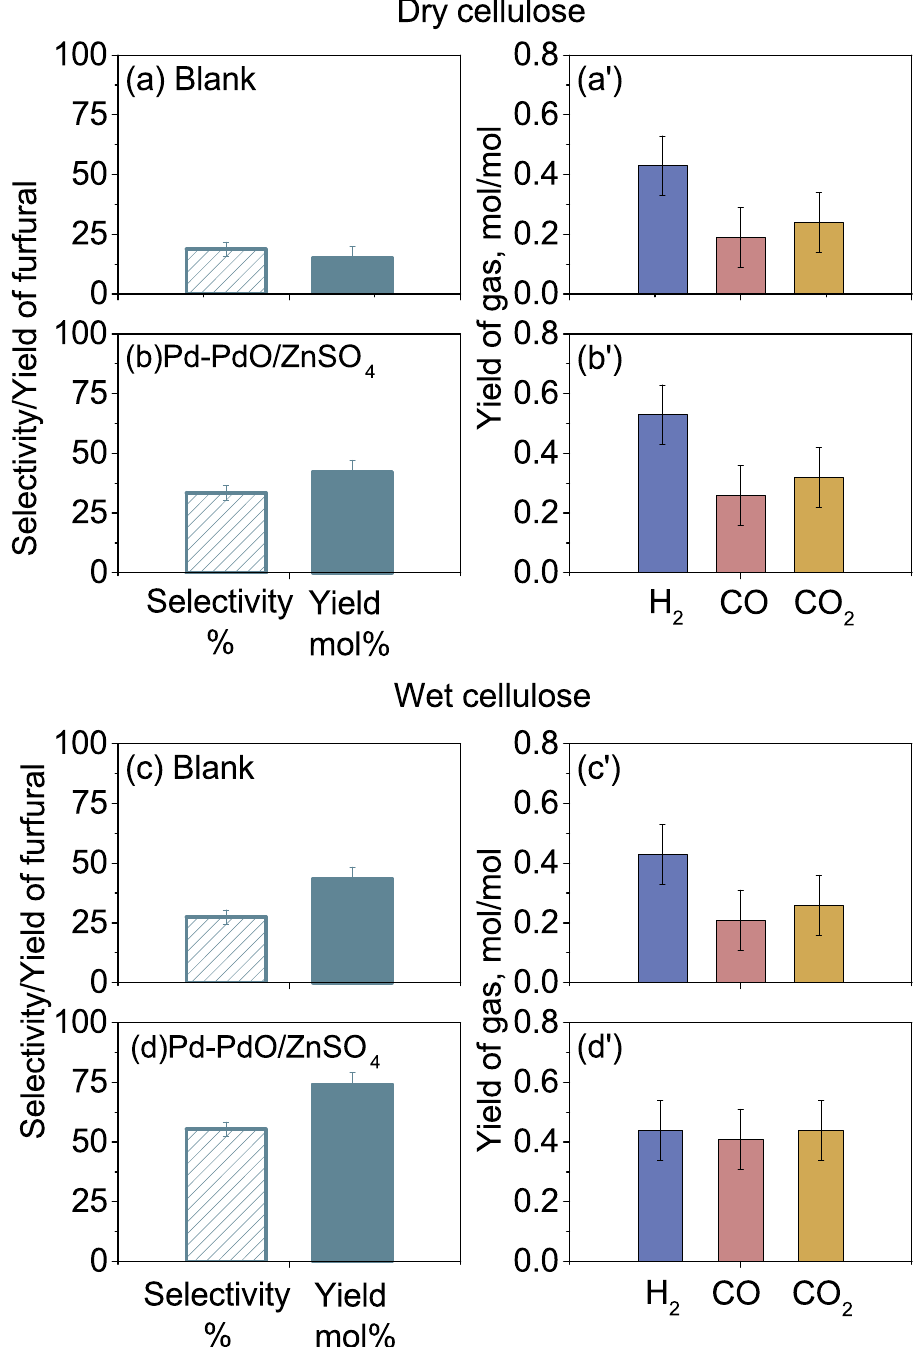
Fig. 5 | Product distribution from the pyrolysis ofdry and wet cellulose. Panels a and a ’ arefortheselectivityandyieldoffurfural,andtheyieldsofindividualgases from dry cellulose without catalysts, respectively; Panels b and b ’ are for the respective results from dry cellulose with the Pd-PdO/ZnSO 4 catalyst; Panels c and